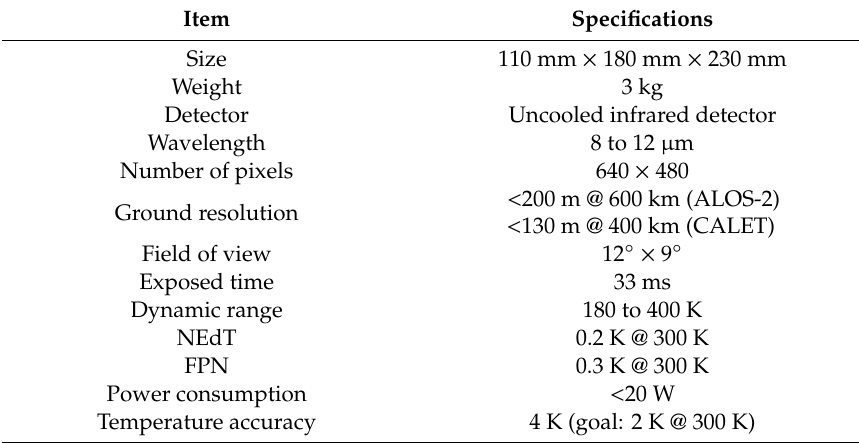
Table 1. Specifications of the Compact Infrared Cameras (CIRC) on board the Advanced Land